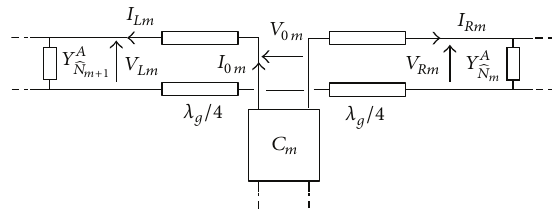
Figure 4: Input node of the 𝑚 th radiating waveguide. The two admittances model the radiating slots ̂𝑁 𝑚+1 (on the left hand).